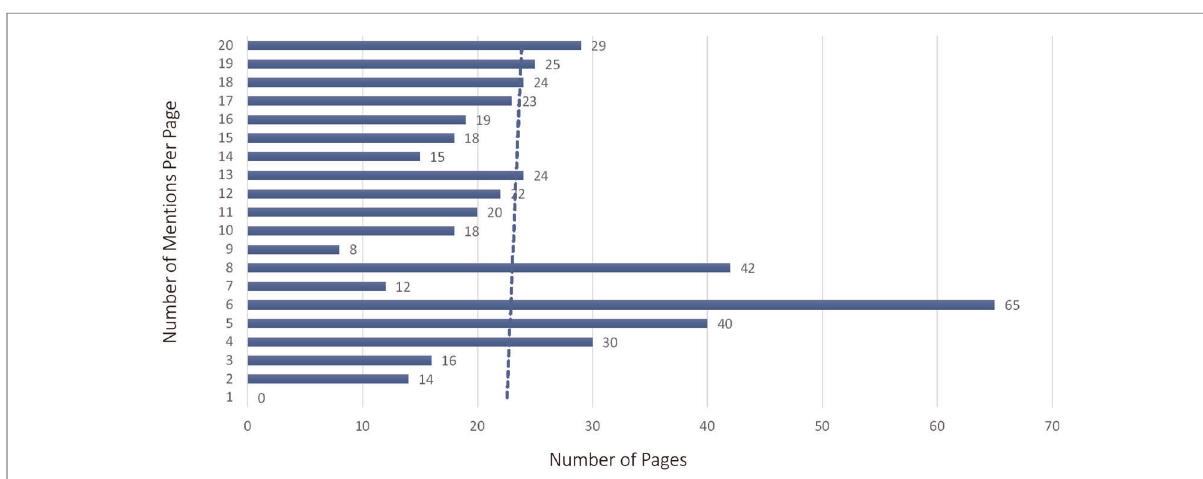
FIGURE 6 Body function mention frequency testing sample by